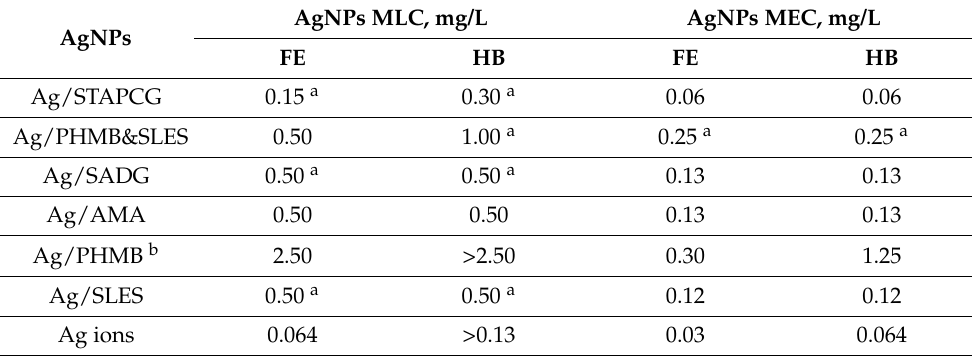
Table 3. Effect of AgNPs on sea urchin